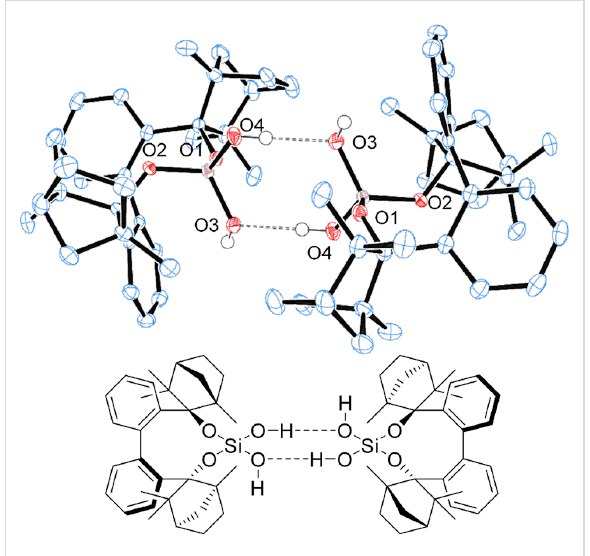
Figure 14: X-ray crystal structure ofrac-BIFOXSi(OH) 2 ( 9 ) forming dimers. H atoms on the chiral backbone are omitted for clarity issues and the ellipsoids are shown with 65% probability. For bond lengths and angles see Table 5.